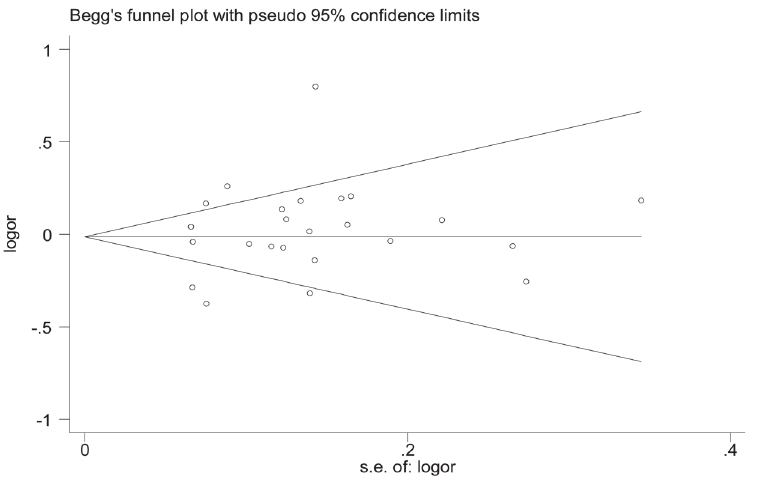
Fig 5. Publication bias on the rs2910164 polymorphism and ADs risk.